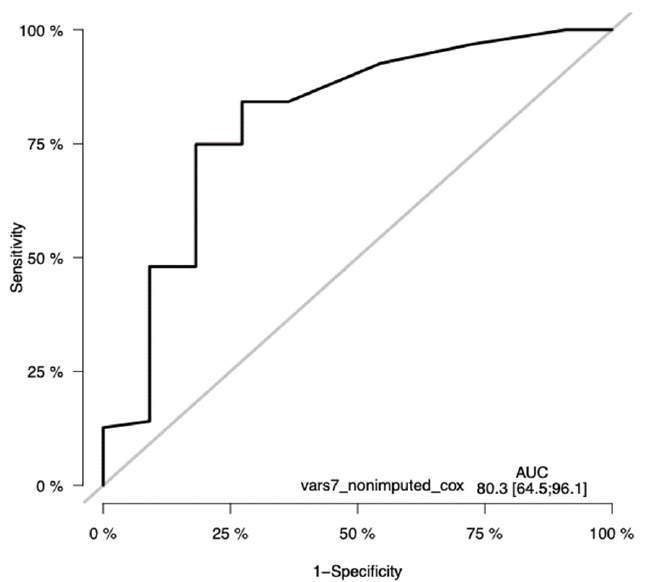
Figure 11. Time-dependent receiver operating characteristic (ROC) curves of the seven-variable Cox PH model at the timepoint of 36 months. The ROC has a significant sensitivity, with an AUC of 80.23(CI 64.5–96.1). The y-axis in the plot displays the true positive rate (TPR)—i.e., sensitivity— whereas the x-axis in the plot displays the false positive rate (FPR), i.e.,